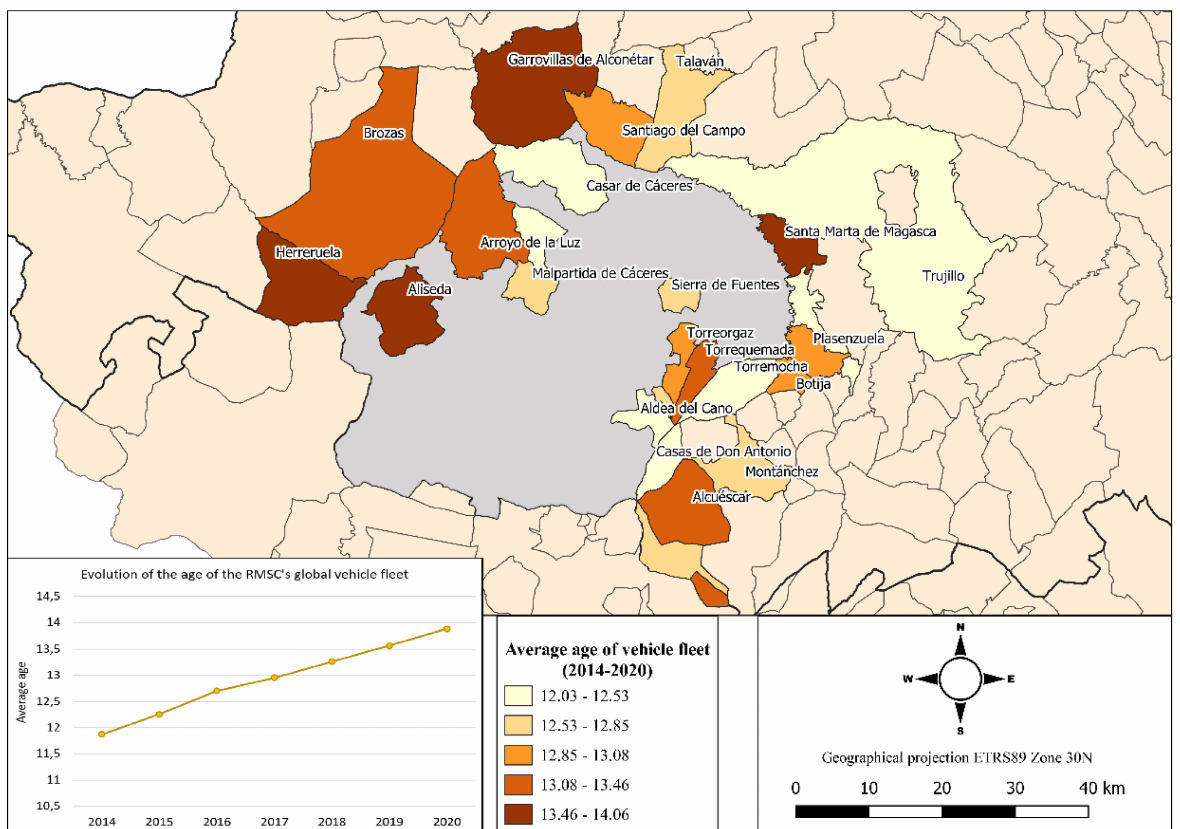
Figure 7. Vehicle fleet age of the RMSC (2014 – 2020).